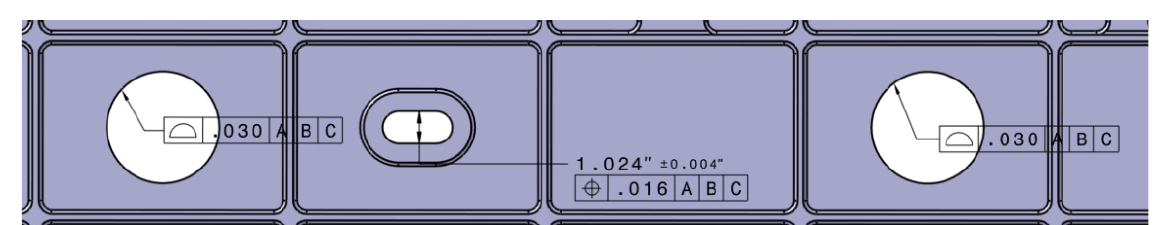
Figure A3. Web cutouts in ISO model.